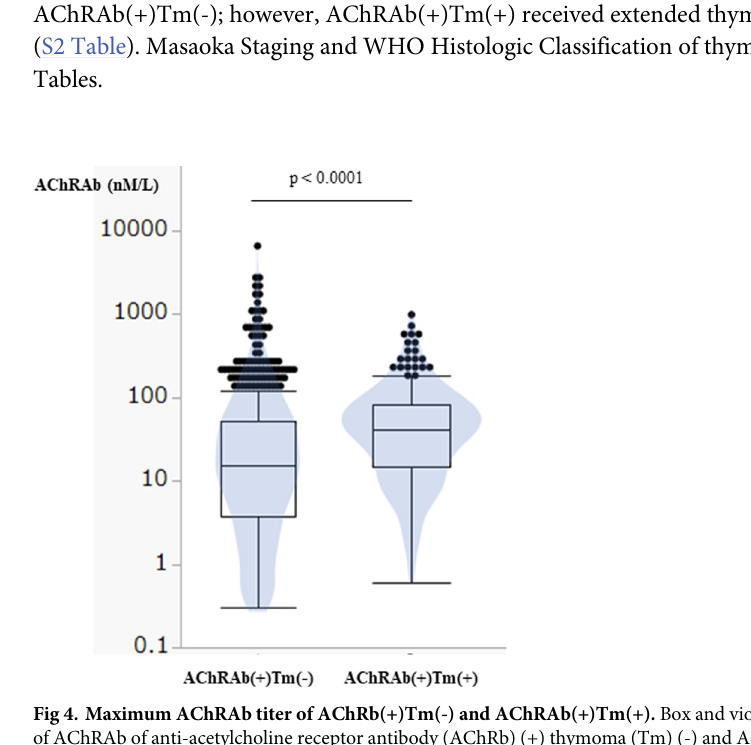
(S2 Table). Masaoka Staging and WHO Histologic Classification of thymoma are in S3 and S4 Tables.